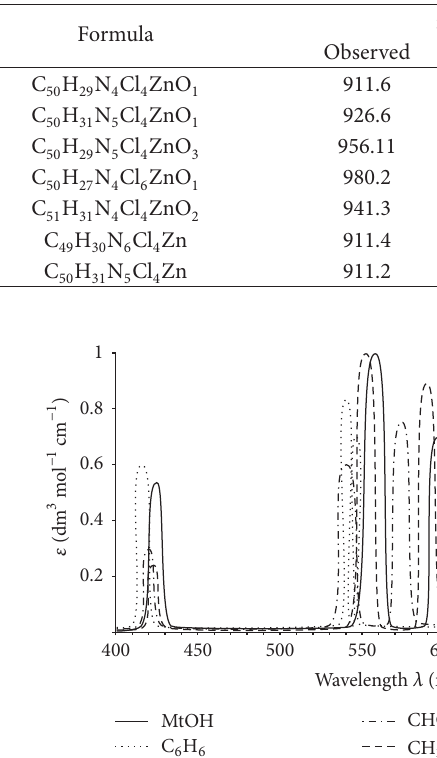
F 5: Optical absorption spectra of p-NH in different